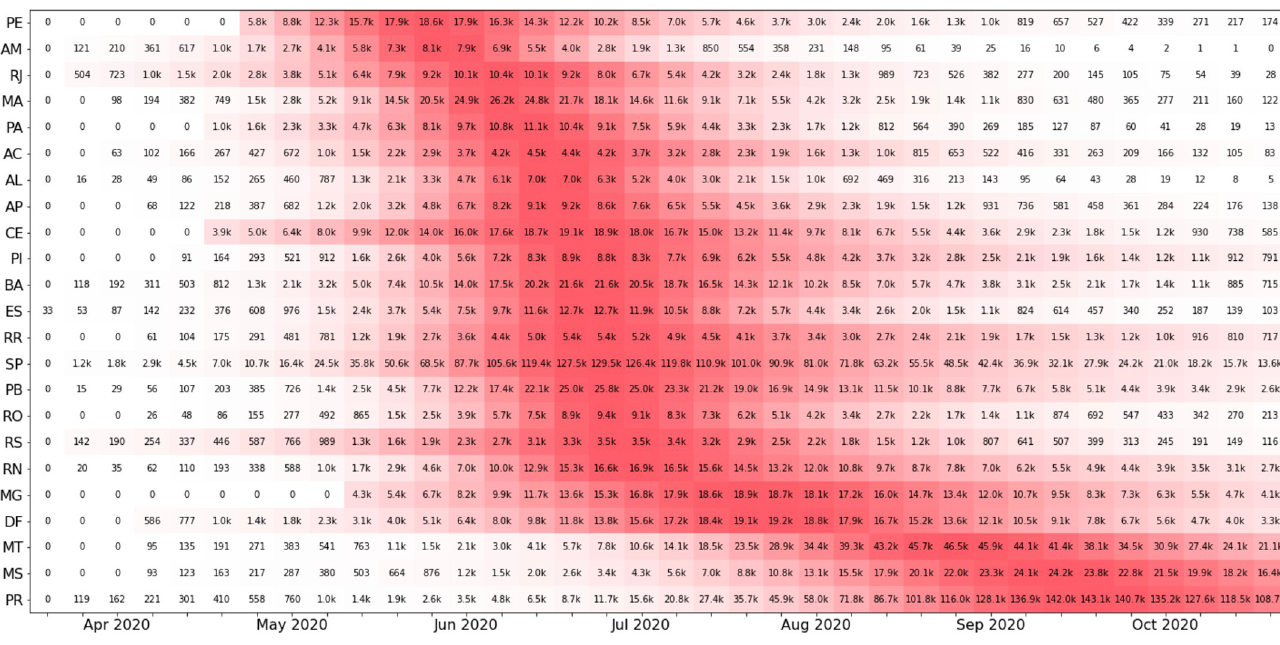
Fig 5. Peak evolution of the epidemic in the Brazilian states illustrated in its temporal sequence of occurrence.